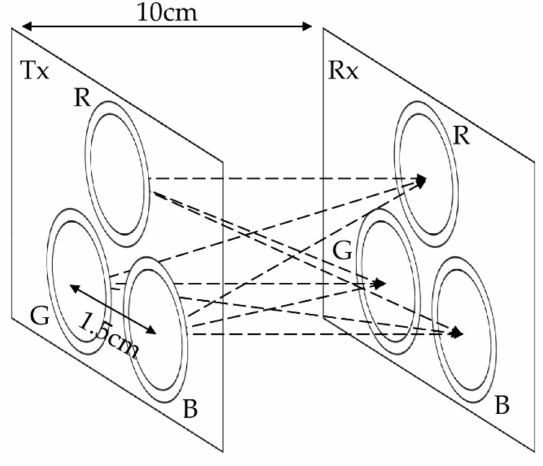
Figure 5. The geometry of the 3 × 3 MIMO LED-to-LED communication